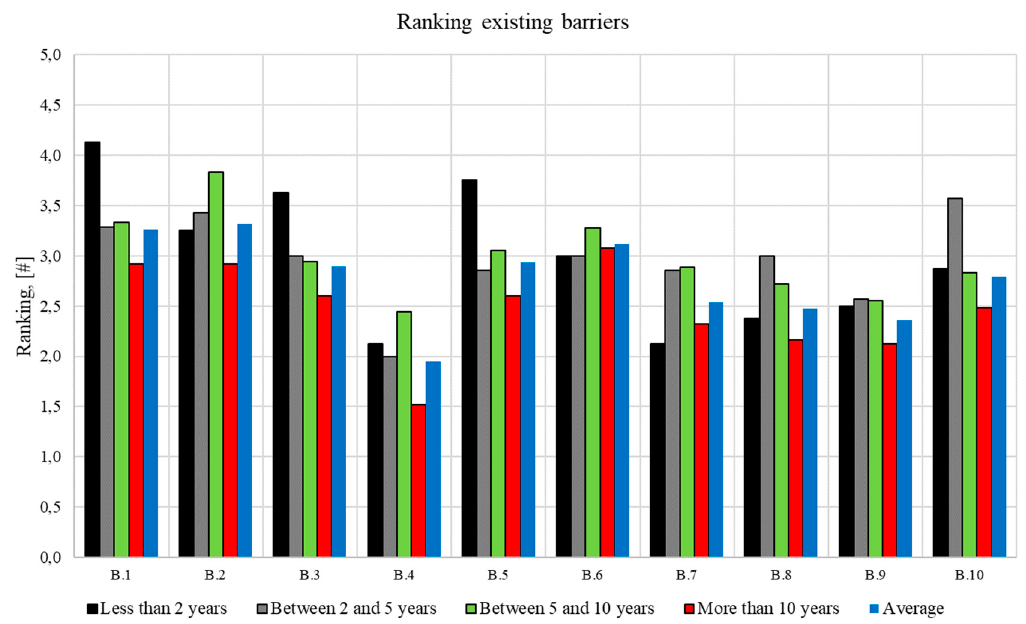
Figure 32 . Ranking of the identified existing barriers as a function of the working experience. Figure 32. Ranking of the identified existing barriers as a function of the working